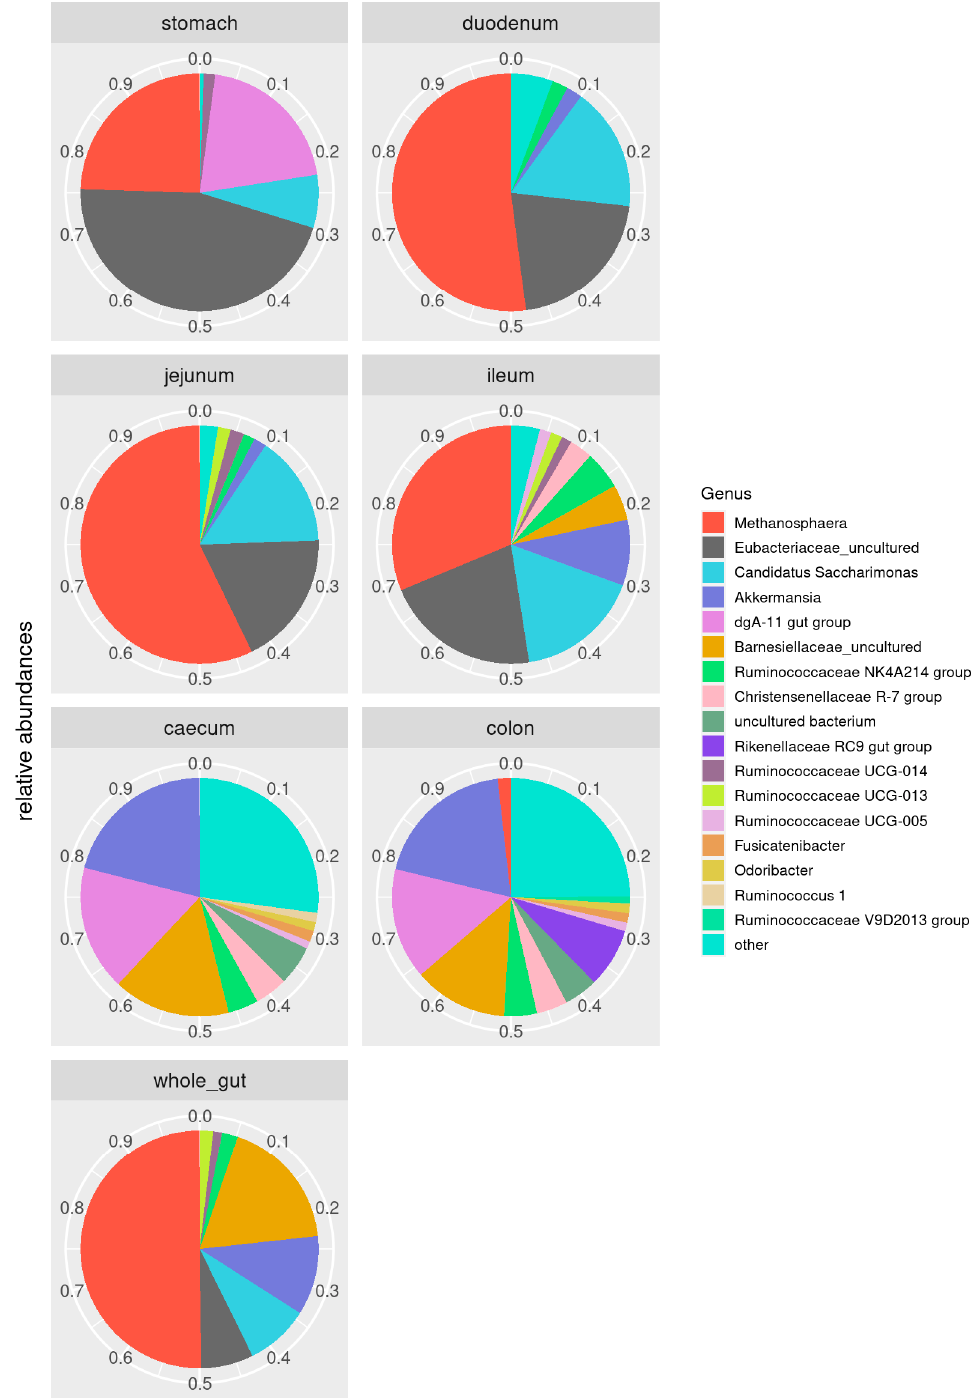
Figure 3. Core microbiota. Composition of the rabbit core gut microbiota (OTUs shared by at least 95% of the samples).